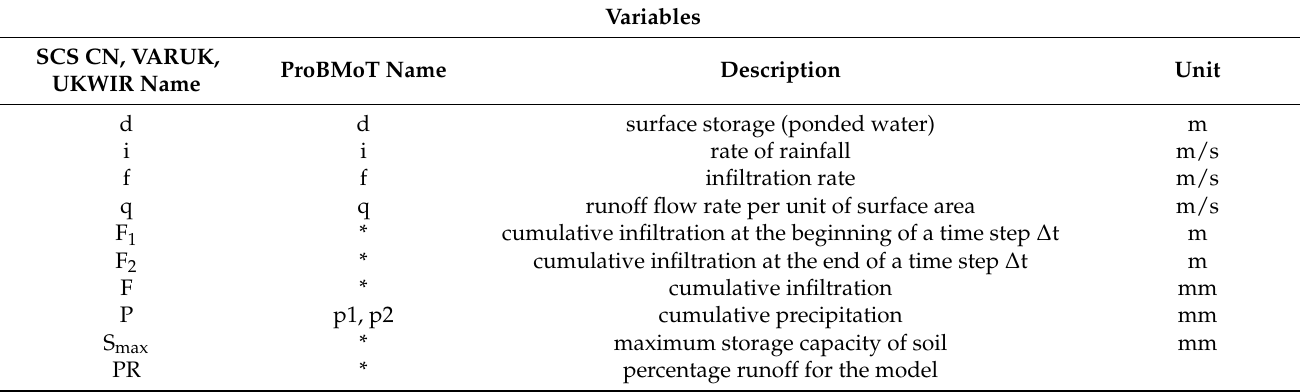
Table 2. Description of variables included in the rainfall-runoff model. Variables